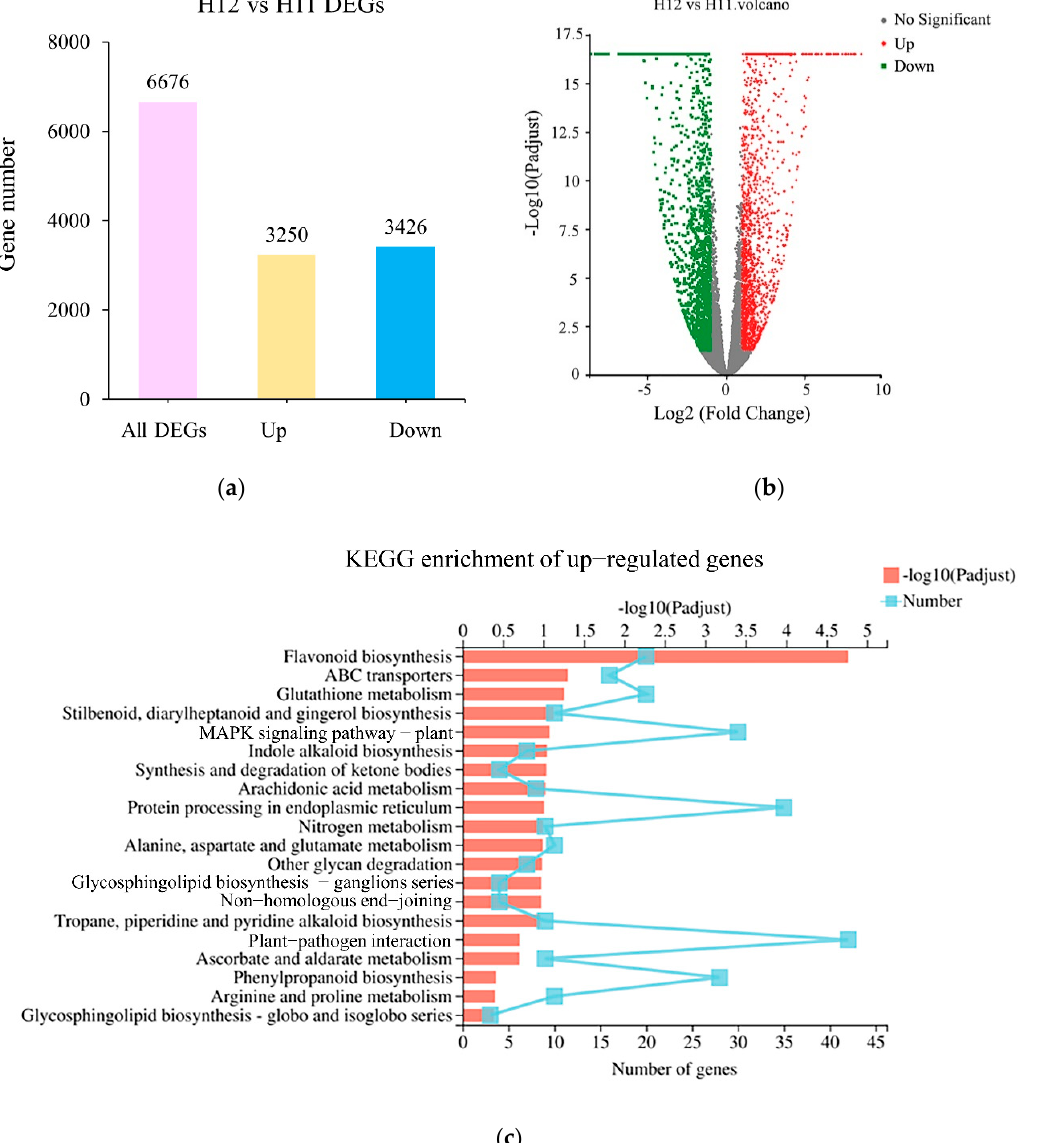
Figure 3. Functional annotation of transcripts in leaf transcriptomes of E. ulmoides among different samples. ( a ) Summary of transcriptome DEGs. ( b ) Volcano plot of transcriptome DEGs. ( c ) KEGG enrichment of up-regulated genes.